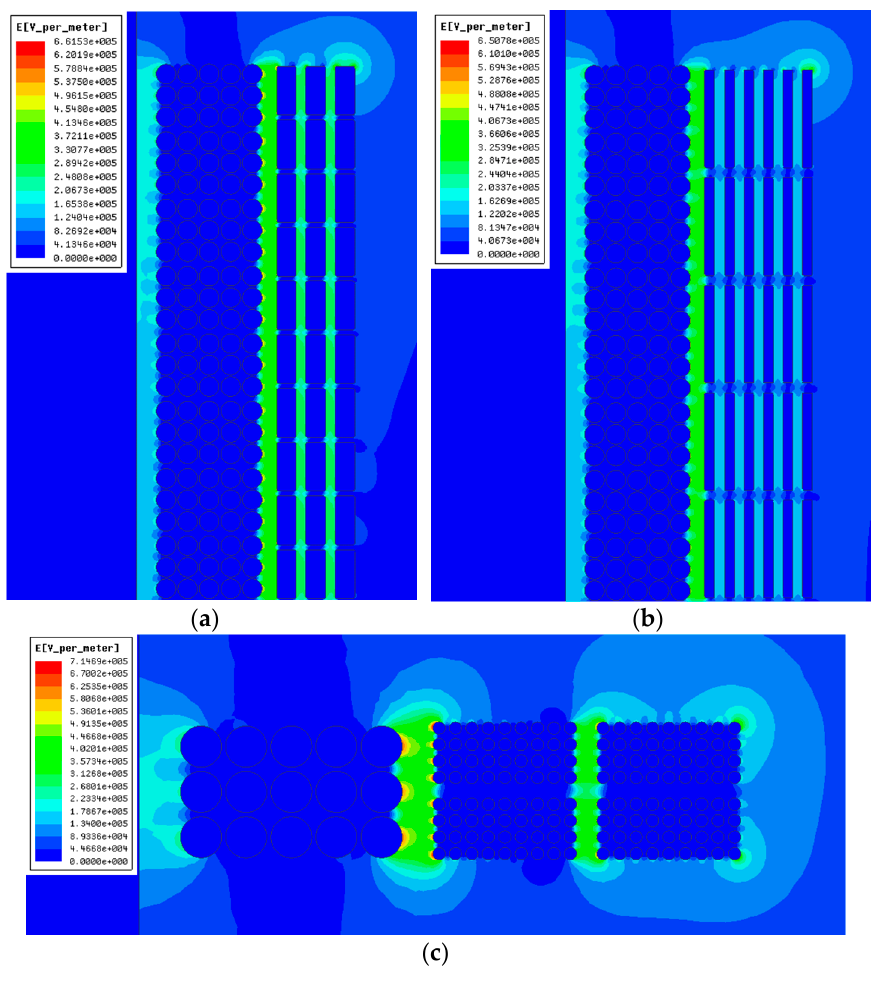
Figure 6. Electric field distribution for different windings: ( a ) N-4; ( b ) N-5; ( c ) N-6. Table 3. Maximum electric field intensities.